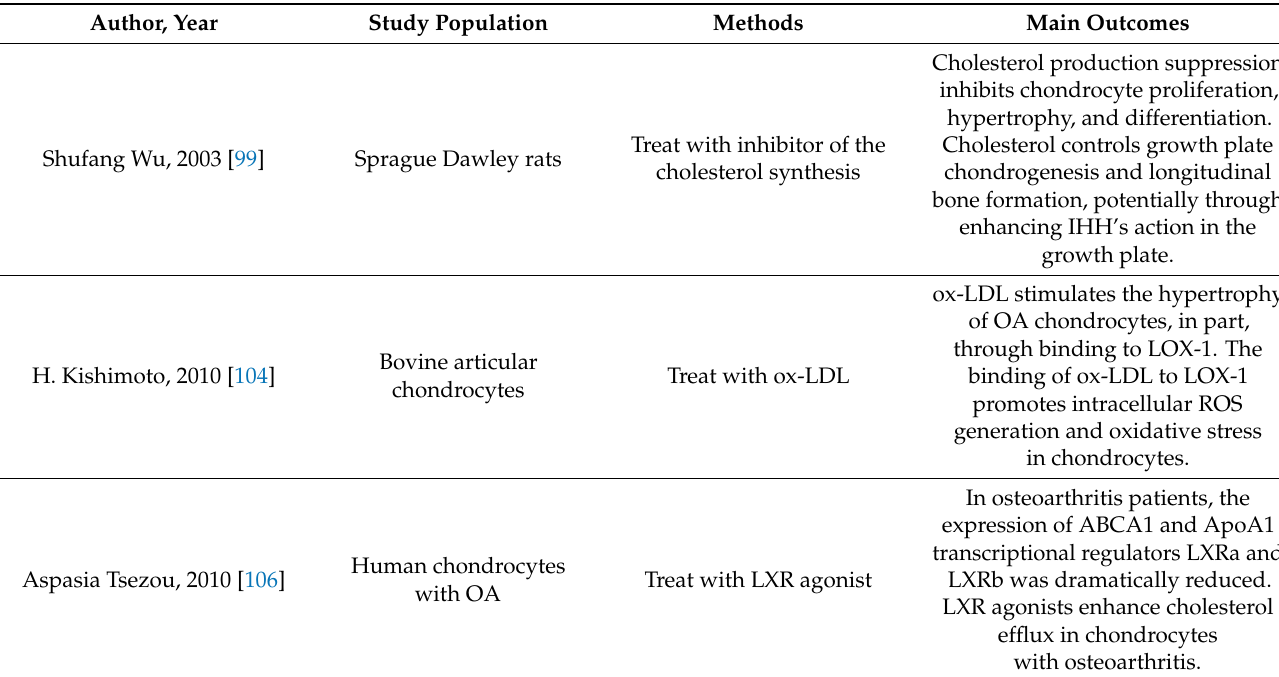
Table 1. Summary of the effects of lipid metabolism on